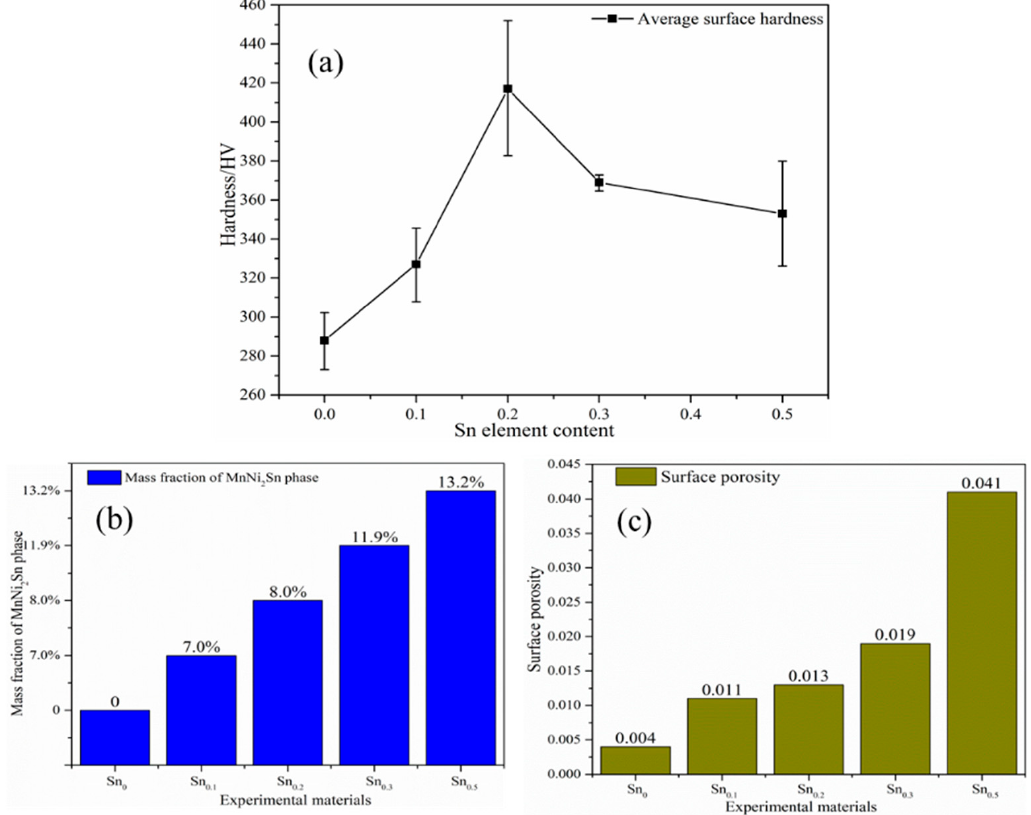
Figure 10. ( a ) Surface microhardness, ( b ) mass fraction of MnNi 2 Sn phase and ( c ) surface porosity of CoCrFeNiMnSn x HEA coatings.